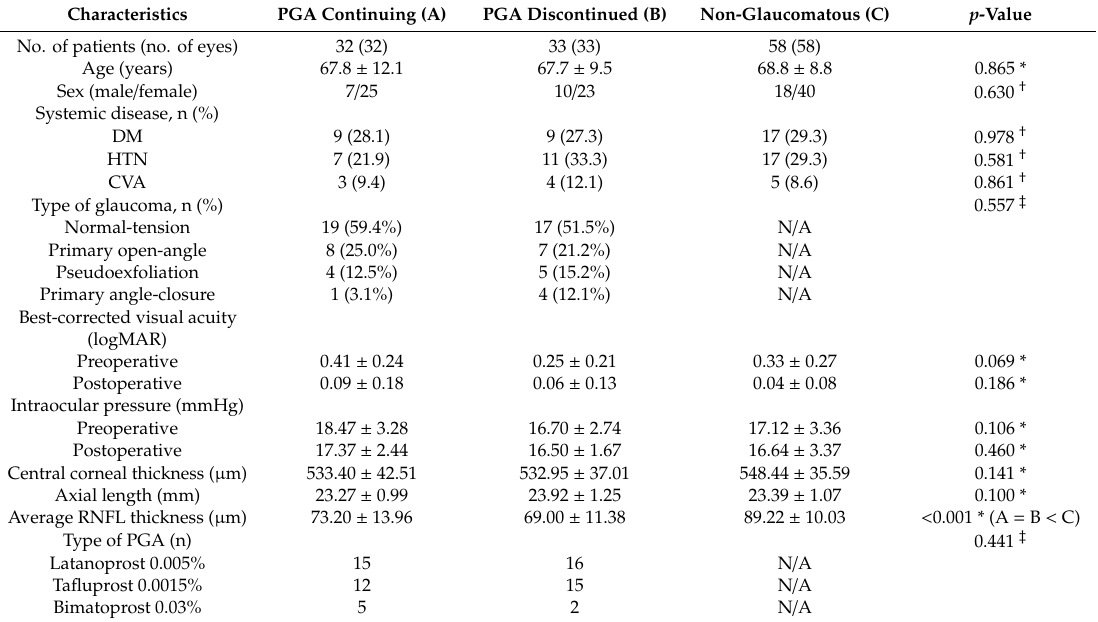
Table 1. Patient demographic and clinical characteristics.